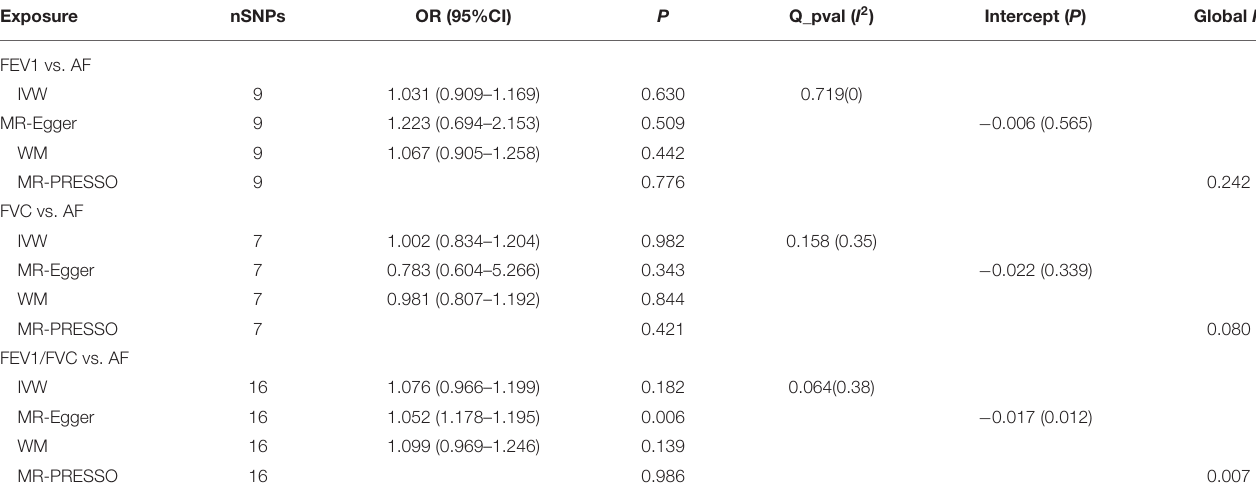
TABLE 3 | Forward causal relations of FEV1, FVC, and FEV1/FVC with AF performed by uvMR. Exposure nSNPs OR (95%CI) P Q_pval ( I 2 ) Intercept ( P ) Global